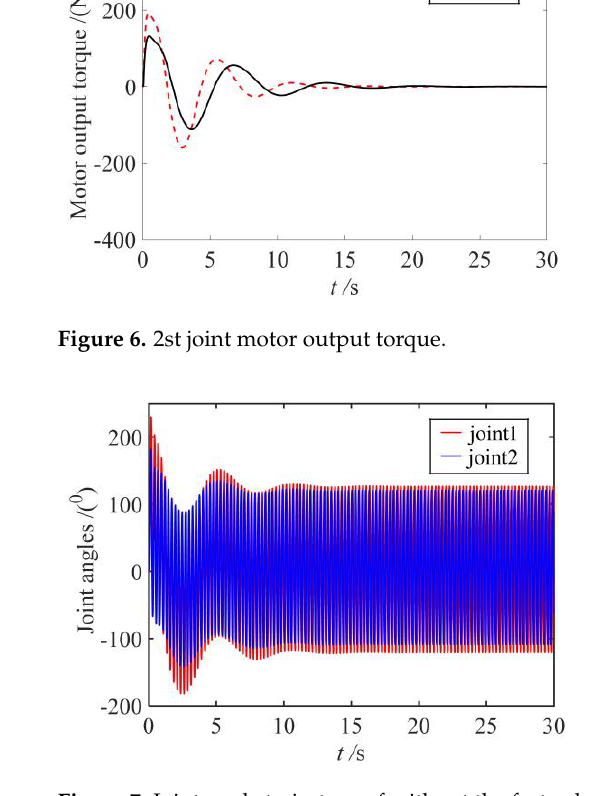
Figure 7. Joint angle trajectory of without the fast subsystem controller.